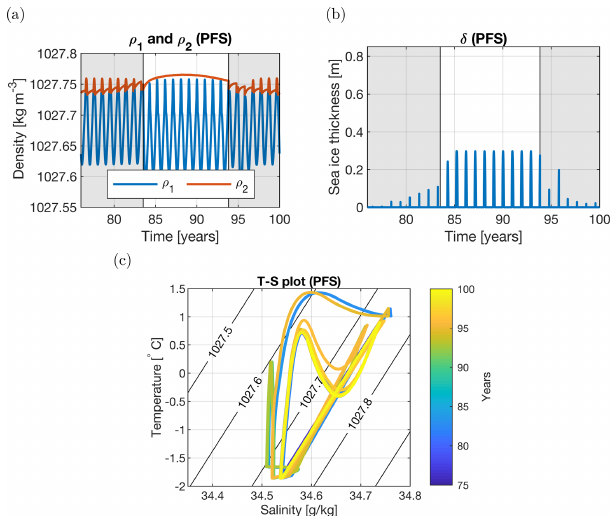
Figure 8. Years 76–100 for the PFB case (both subsurface fluxes). (a) Density of the surface (blue) and subsurface (red) layer. (b) Sea- ice thickness. The shading in panels (a) and (b) represents polynya years. (c) T – S plot of the temperature and salinity of the surface layer. The coloring of the lines represents time, ranging from year 76 (blue) to year 100 (yellow). The black contour lines represent the density (in kgm − 3 ). Polynyas are present in year 76 (blue), between years 78 and 81 (blue to cyan), between years 96 and 97 (orange), and in year 99 (yellow).